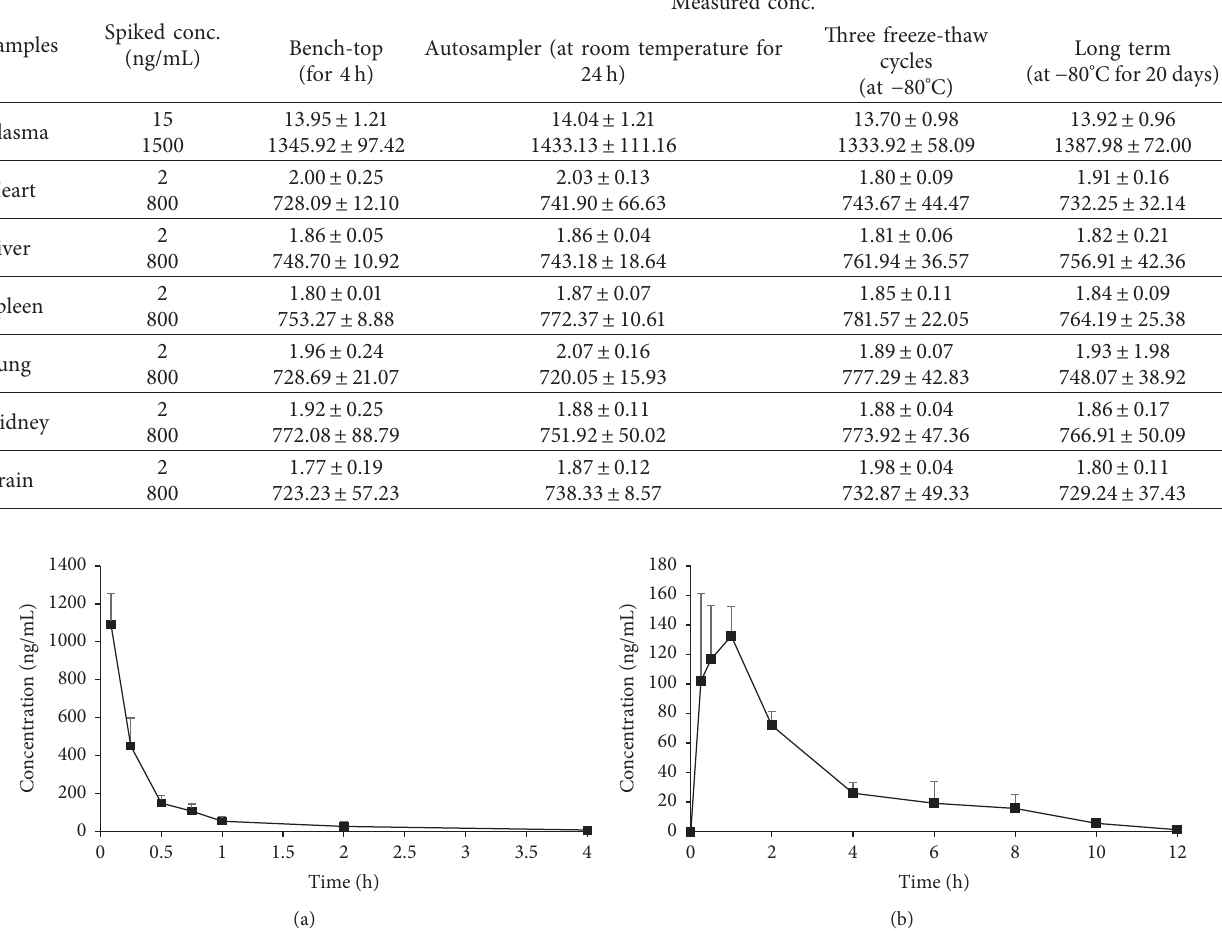
Table 4: Stability of Schisandrol B in rat plasma and tissues homogenate samples under various conditions ( n � 6). Spiked conc. Samples